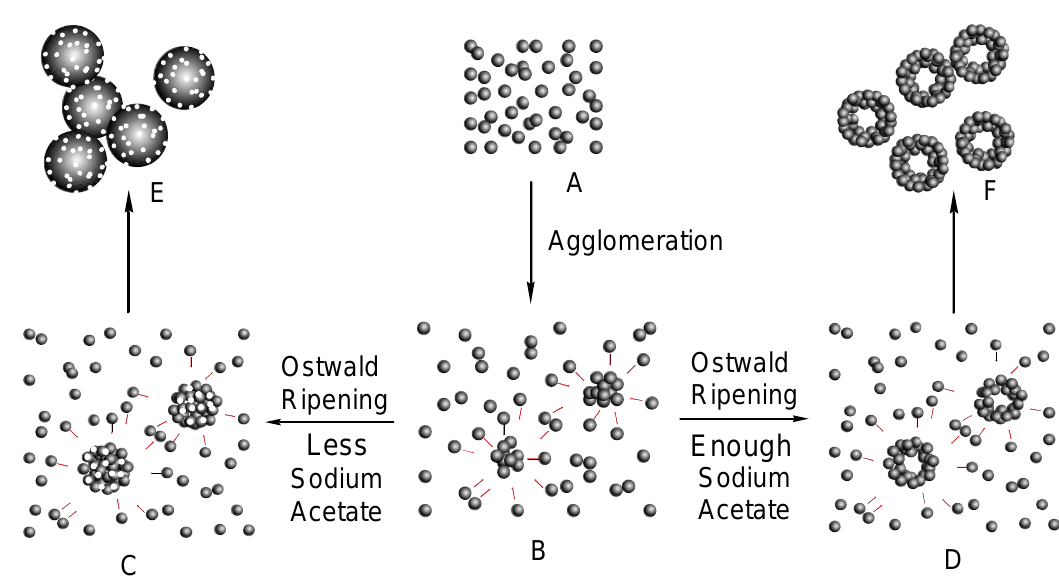
Figure 13. Schematic illustration of the process of magnetite mesoporous hollow spheres formation.